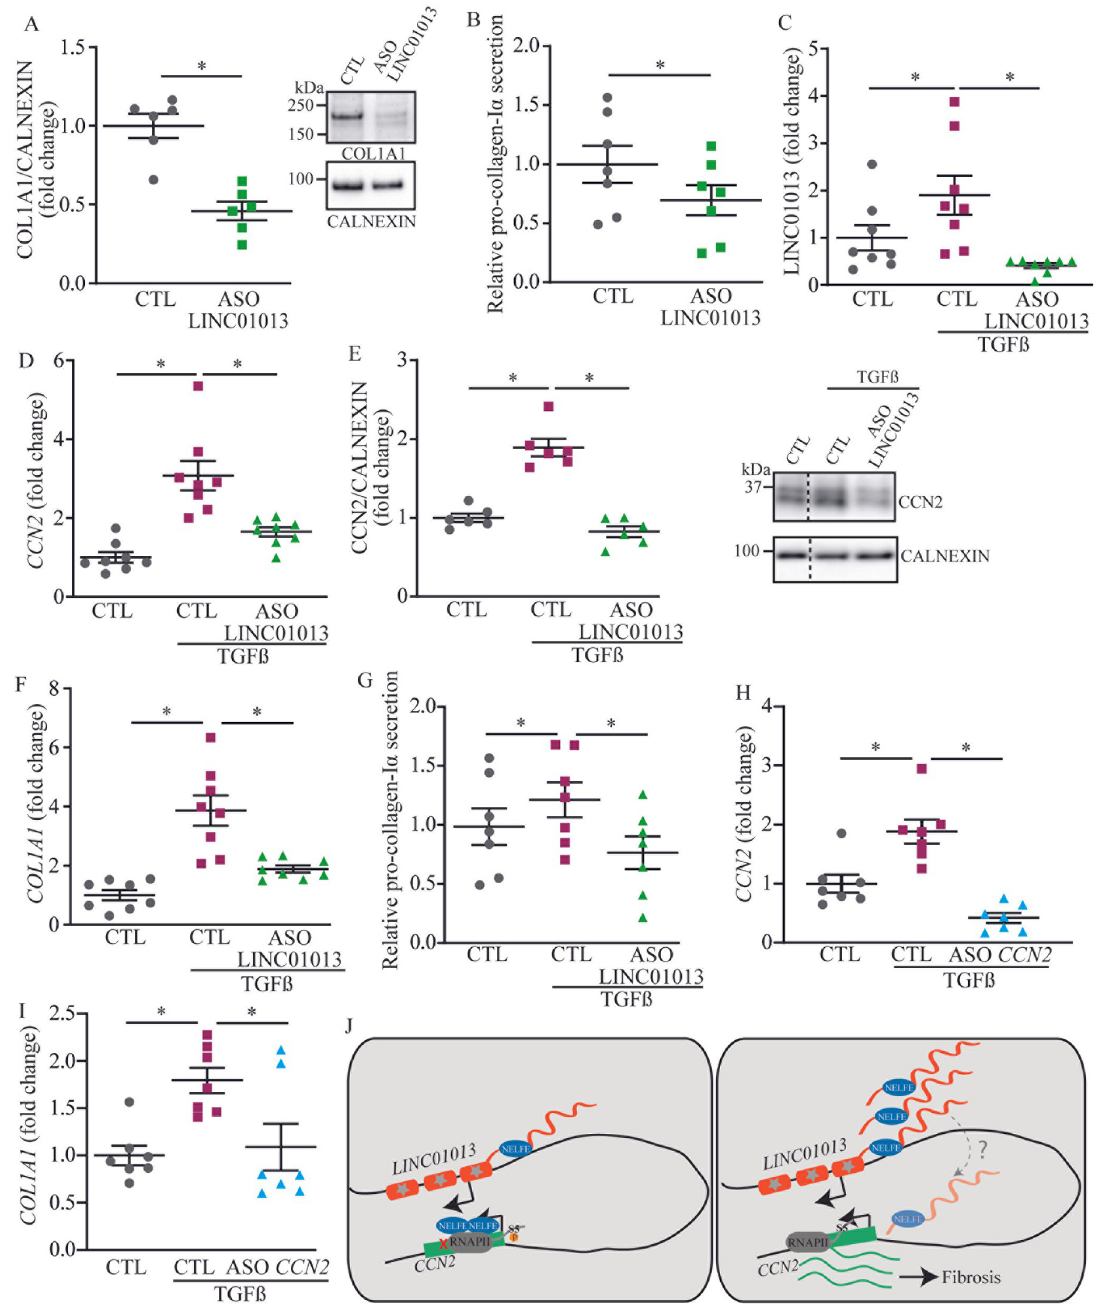
Fig 6. TGF- β mediates LINC01013 activation. A-B) Western blot (n = 6) (A) and pro-collagen-I α measurements (n = 7) (B) indicate decreased collagen following LINC01013 ASO treatment. C) TGF- β treatment induces LINC01013 expression (n = 8). D-E) TGF- β - mediated increase of CCN2 mRNA expression (n = 8) (D) and protein level (n = 6) (E) rely on LINC01013 expression. F-G) The rise in COL1A1 expression (n = 8) and pro-collagen-I α secretion (n = 7) following TGF- β treatment relies on LINC01013 expression. H) TGF- β promotes CCN2 expression (n = 7). I) CCN2 ASO (H) negates TGF- β -induced COL1A1 expression level (n = 7). J) Cartoon illustrates the process whereby LINC01013 controls the expression of CCN2 ; dashed line is a hypothetical process as a direct interaction of LINC01013 with DNA at the CCN2 locus remains to be demonstrated.